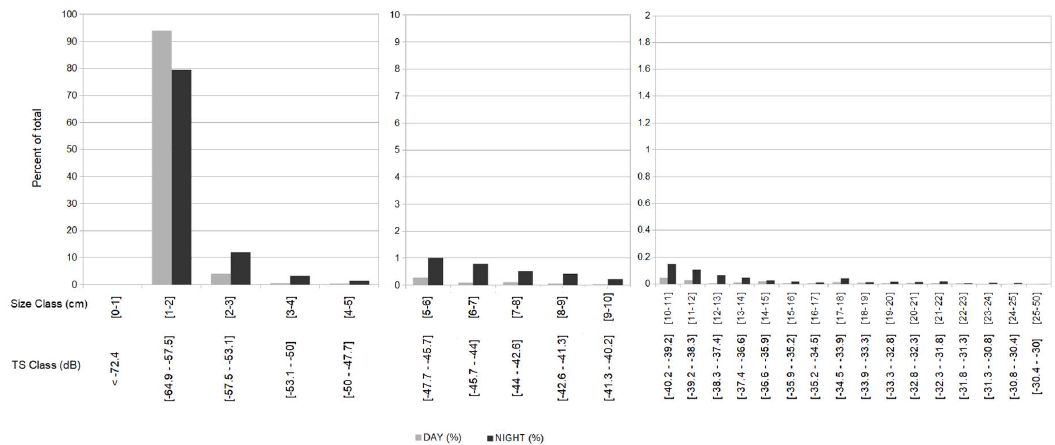
Figure 11. The size (total length, cm) and Target Strength (dB) distribution of pelagic fish recorded during night and day vertical surveys in Lake Trichonis.